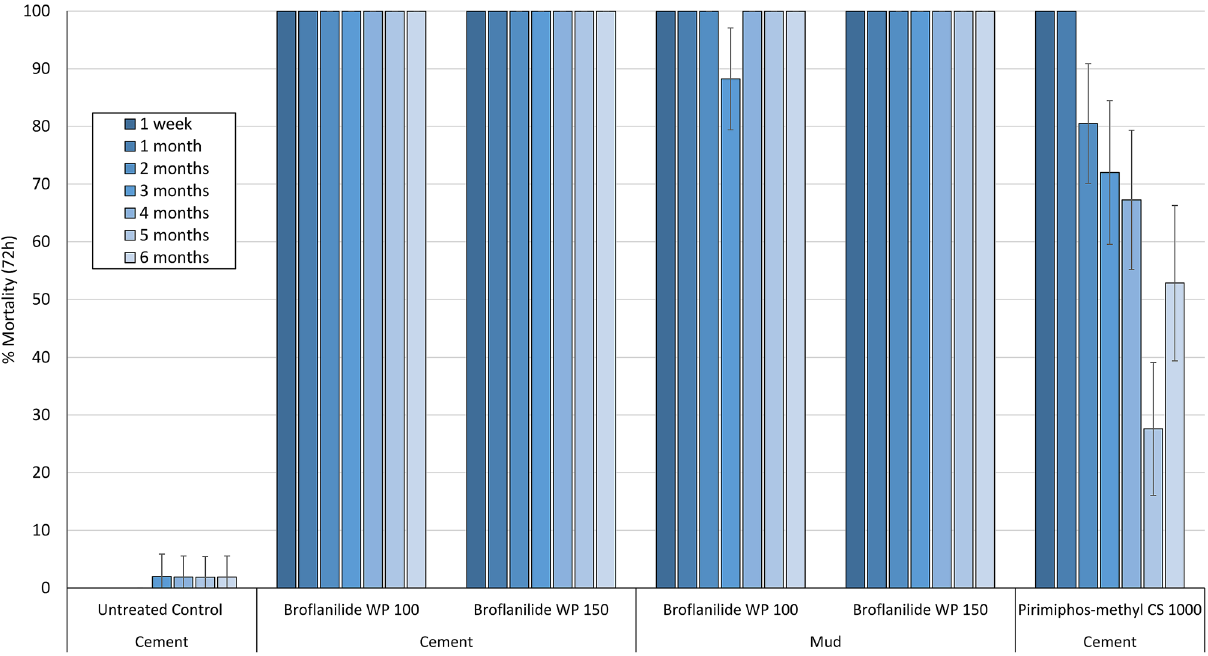
Figure 6. Cone bioassays mortality (72 h) with susceptible An. gambiae ss Kisumu on broflanilide WP treated experimental hut walls. At each monthly interval, ~ 50 2–5 days old female mosquitoes were exposed on treated walls of each hut in cohorts of 10 per cone. Error bars represent 95% confidence intervals.